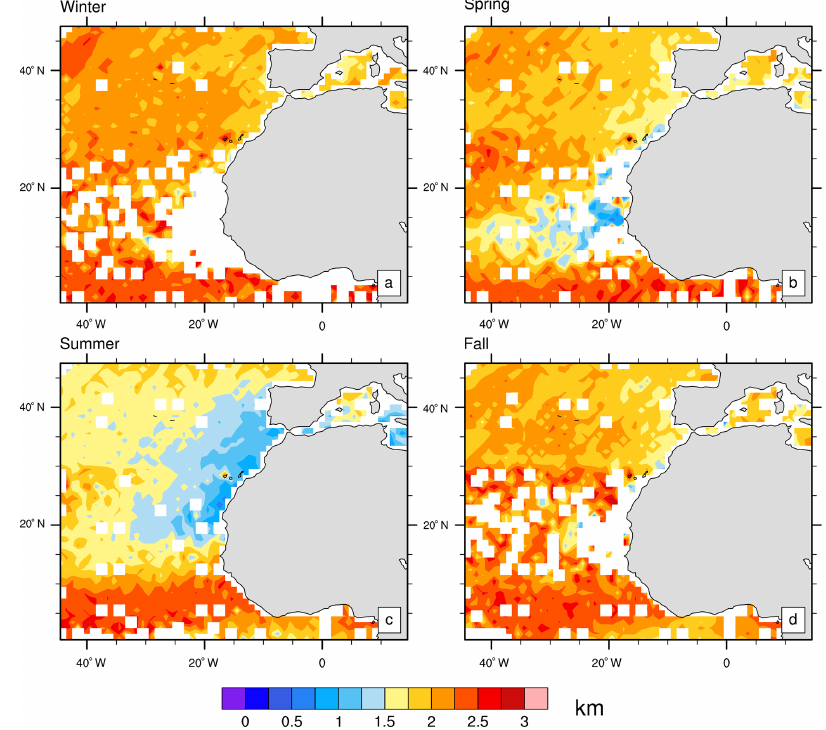
Figure 9. Marine stratocumulus cloud-top height from CERES in (a) winter, (b) spring, (c) summer, and (d) fall.